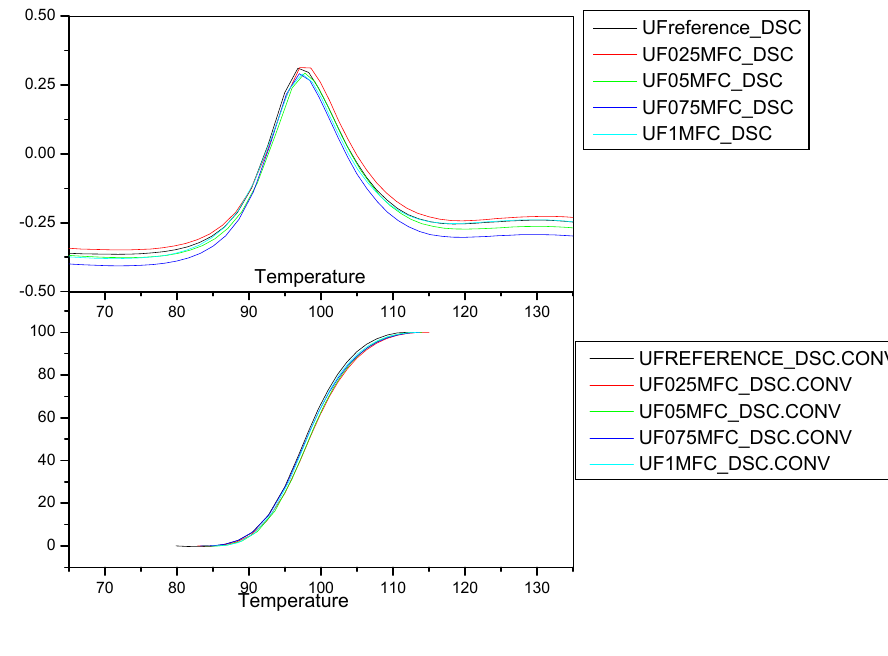
Figure 3. DSC curves, Experiment 3.1.2.